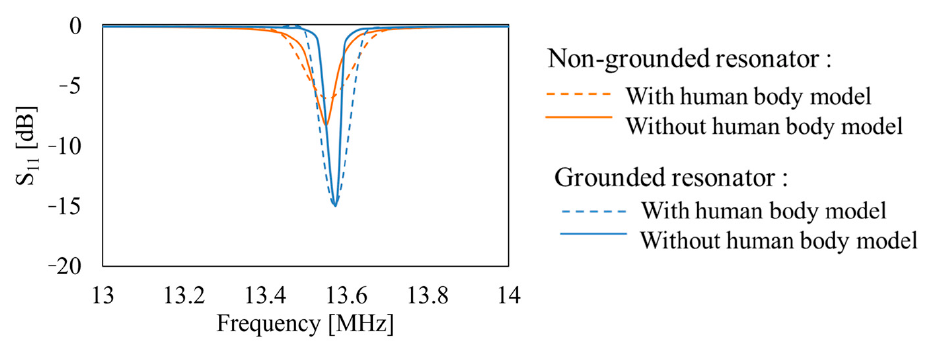
Figure 6. S parameters (S 11 ) for the two resonators.